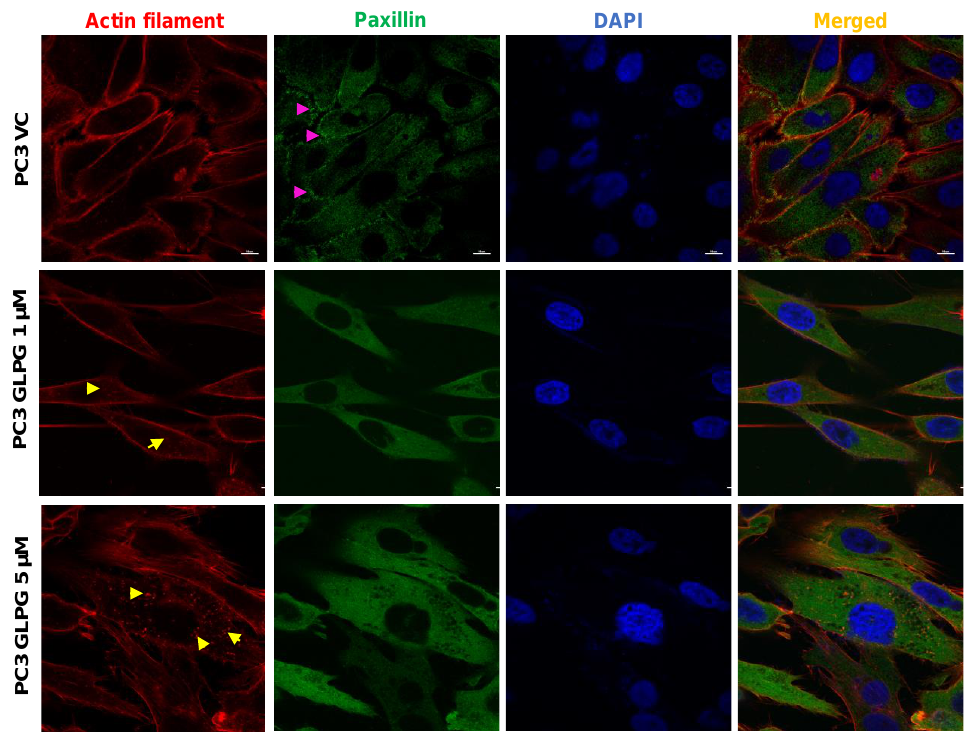
Figure 4. MK5 regulates the formation of focal adhesions in the lamellipodial extensions of mi- gratory PC3 cells. Immunostaining of paxillin along with rhodamine phalloidin–mediated actin staining to determine the localization of focal adhesions in PC3 cells treated with different doses of GLPG. Images are the representation of three independent experiments ( n = 3). Scale bar = 10 µ m. The pink arrow represents paxillin localization in the lamellipodial extensions in the vehicle control (VC) treated cells, while the yellow arrow represents the condensed actin foci in the basal surface of the GLPG-treated